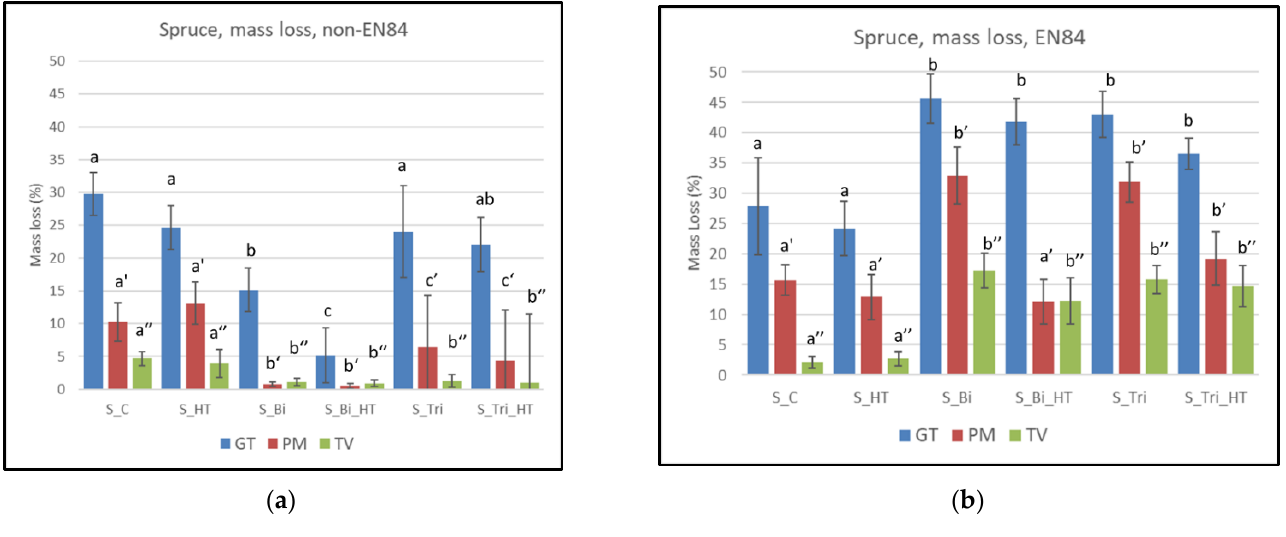
Figure 6. Mass loss of spruce as a result of fungal decay, ( a ) without EN84 weathering; ( b ) with EN84 weathering. GT— G. trabeum , PM— P. monticola, TV— T. versicolor . Tukey analysis groups shown above each bar graph.